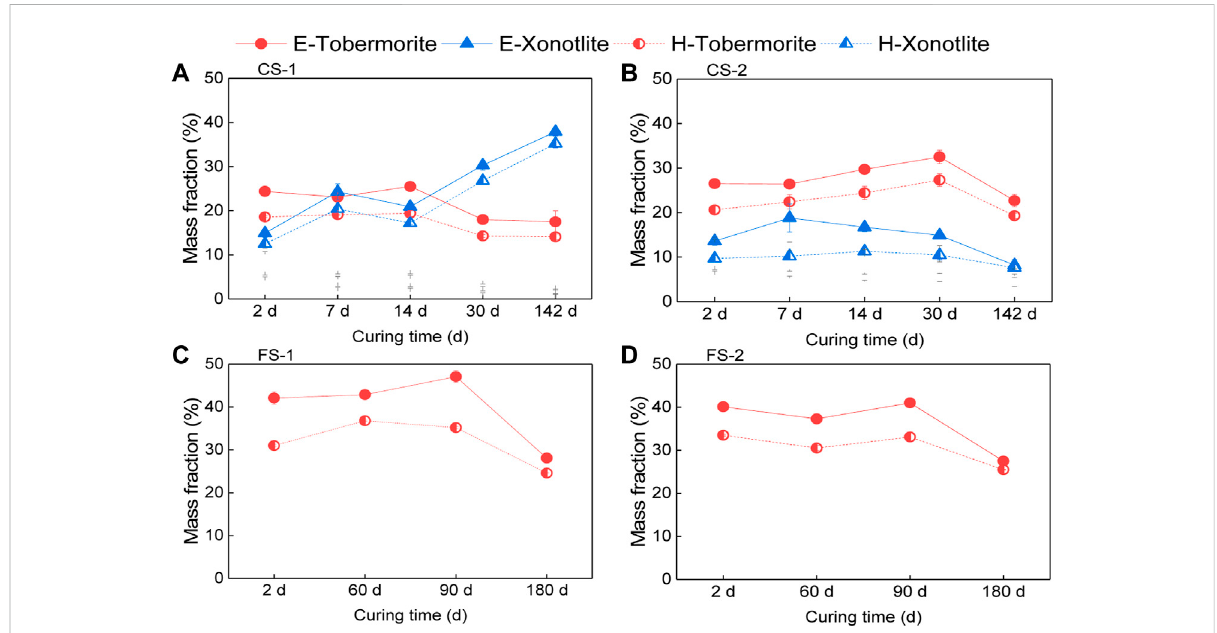
FIGURE 11 Comparisonofthecrystallinephasecontentsobtainedbydifferentmethods.(E:theexternalstandardmethod;P:thePONKCSmethods;H:the hybrid method). (A) slurry CS-1 (B) slurry CS-2 (C) slurry FS-1 (D) slurry